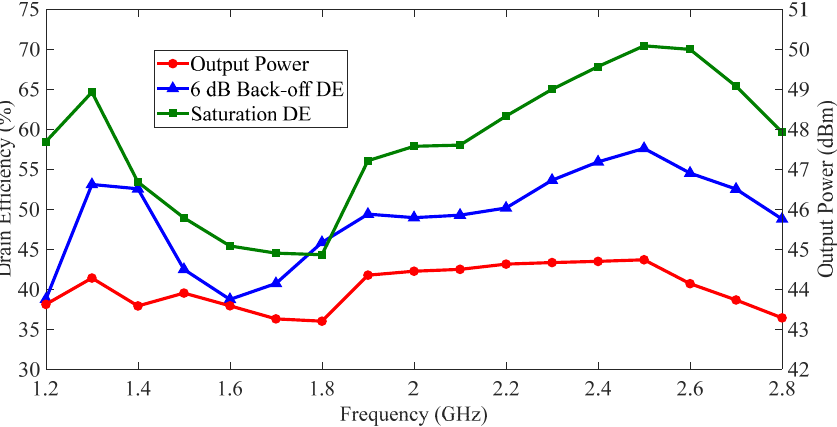
Figure 13. Measured output power and drain efficiency of the fabricated DPA versus